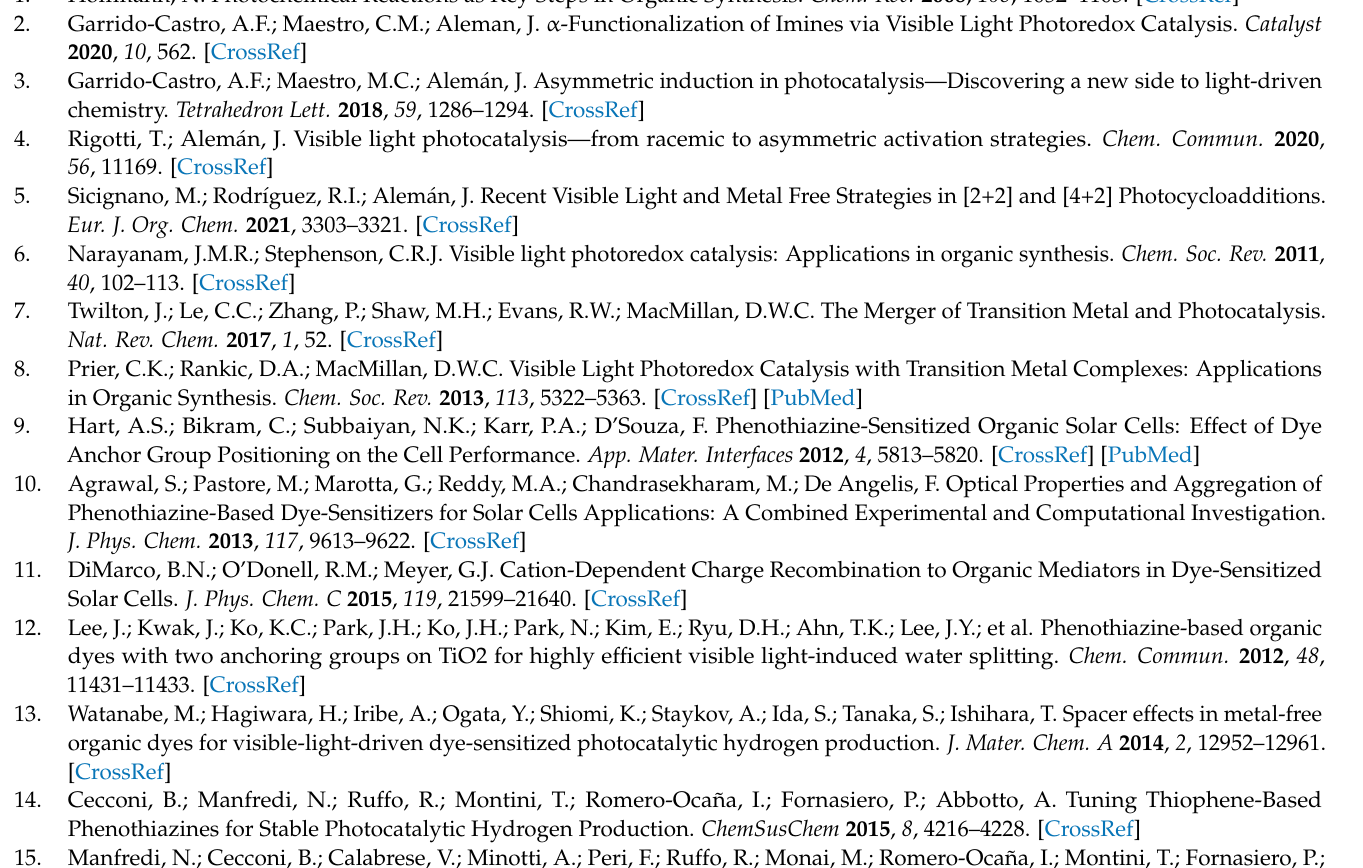
Figure S5: 1H-NMR spectrum of 4,4 (cid:48) ,4 (cid:48)(cid:48) -(phenothiazine-3,7,10-triyl)tribenzaldehyde, Figure S6: 1H- NMR spectrum of Sulfoxidation reaction crude spectra of sulfide 1a under optimized conditions (19 h), Figure S7: 1H-NMR spectrum of Sulfoxidation reaction crude spectra of sulfide 1b under optimized conditions (15 h), Figure S8: 1H-NMR spectrum of Sulfoxidation reaction crude spectra of sulfide 1c under optimized conditions (8 h), Figure S9: 1H-NMR spectrum of Sulfoxidation reaction crude spectra of sulfide 1d under optimized conditions (4 h), Figure S10: Measurement of light emitted by LED source used in photocatalytic